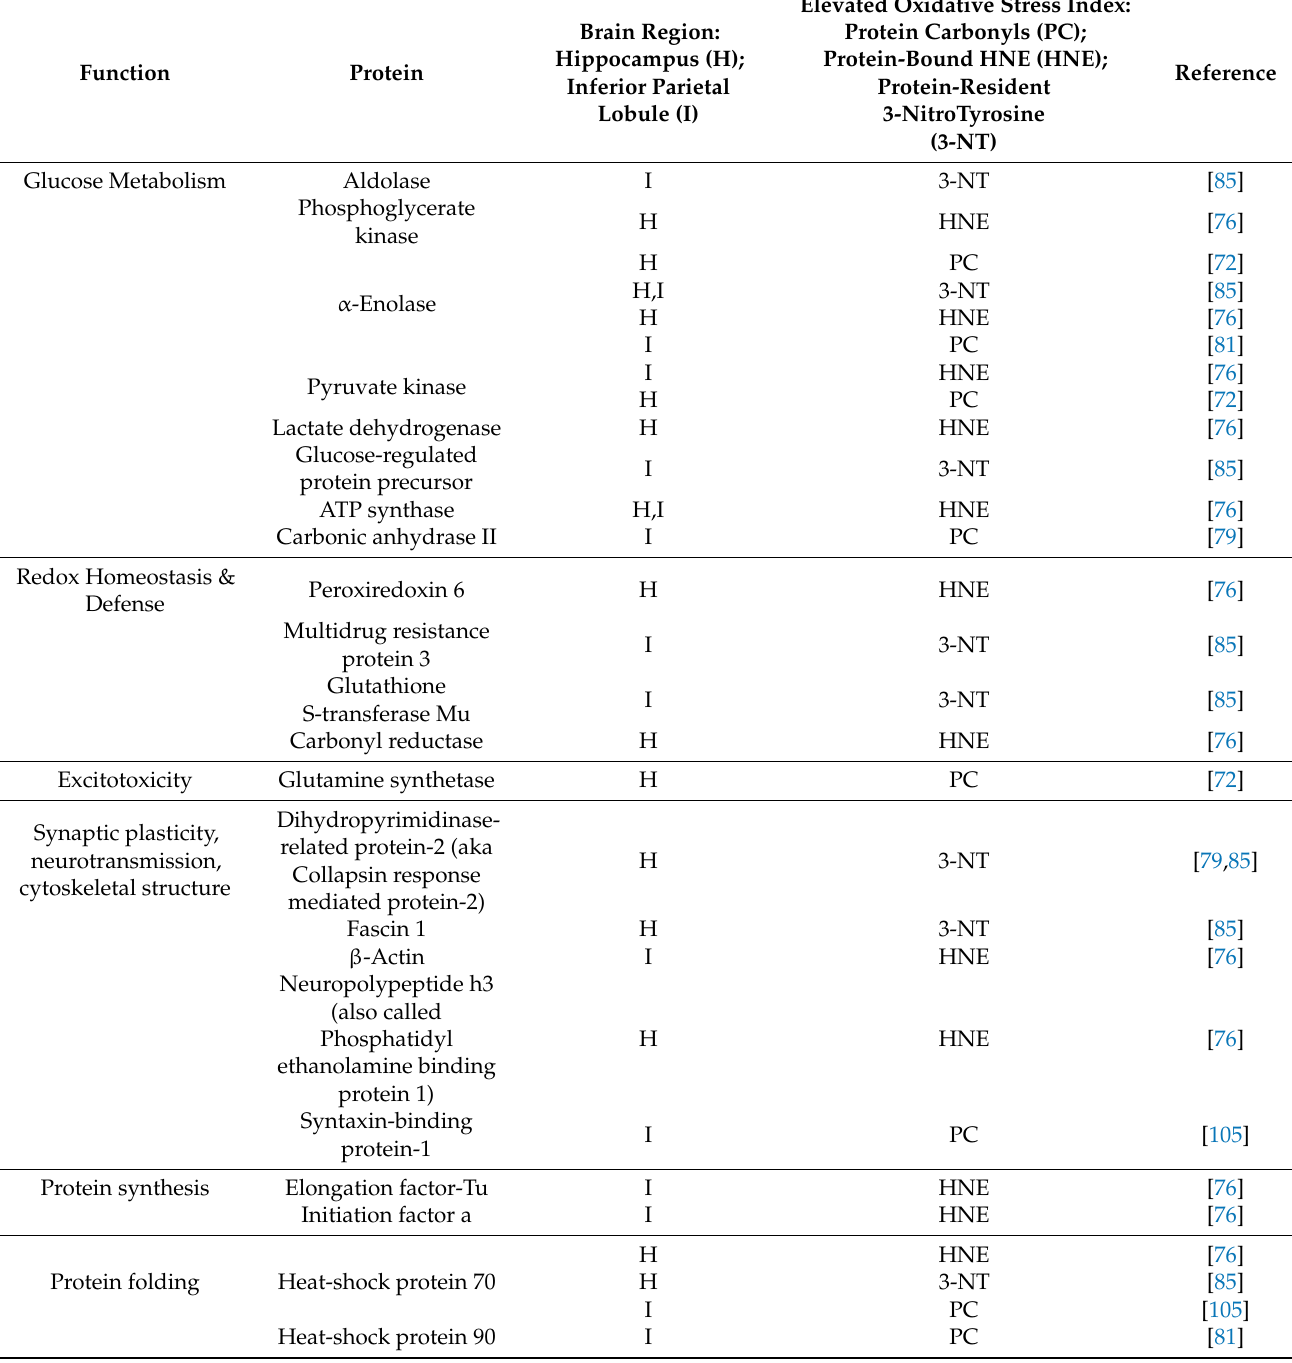
Table 1. Oxidatively modified proteins and their corresponding functional grouping from different brain regions in MCI compared to control